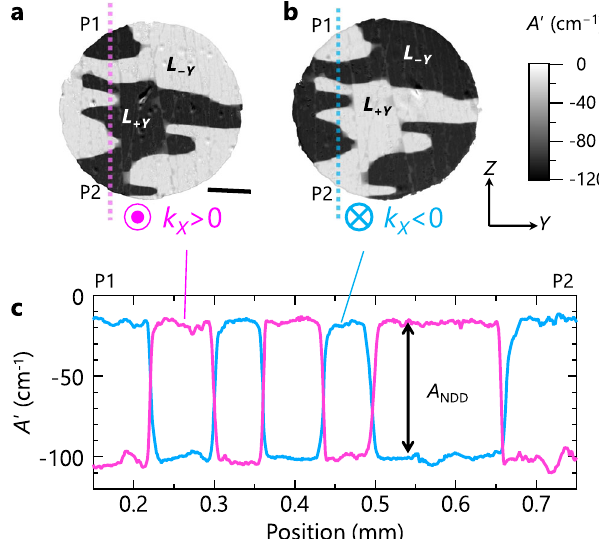
Fig. 3 Antiferromagnetic domains after zero- fi eld cooling. a , b Two- dimensional spatial distribution of A ʹ for k X > 0 ( a ) and k X < 0 ( b ) of an X - plane sample at 5 K and at 0 T after zero- fi eld cooling. Here, A ʹ is the variation of absorption coef fi cient from 50 K (> T N ). E ω is parallel to the Y axis and light wavelength is 750nm. Dark and bright regions in (a) correspond to the L + Y and L − Y domains, respectively, while those in (b) correspond to the L − Y and L + Y domains, respectively. Scale bar below ( a ) is 0.2 mm. c Pro fi les taken along the same line from P1 to P2 in ( a ) (magenta) and ( b ) (sky blue), respectively. The difference between the two pro fi les at the same position corresponds to nonreciprocal directional dichroism, A NDD